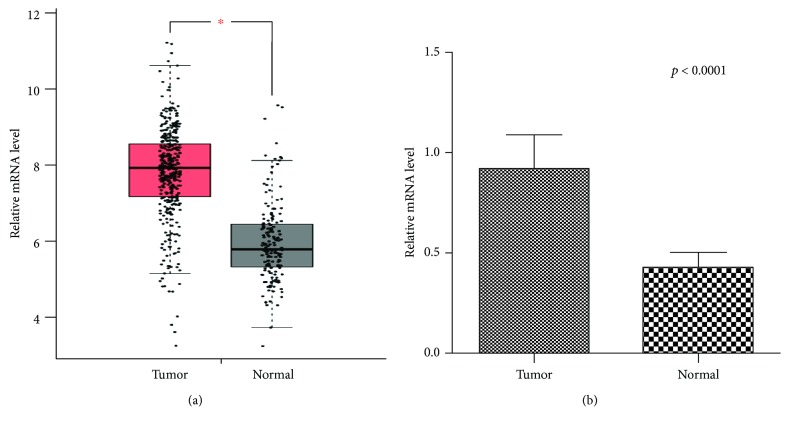
qRT-PCR analysis of ANXA2P2 expression levels in tumor and nontumor tissues of hepatocellular carcinoma patients. (a) 369 cases of hepatocellular carcinoma (HCC) tissues and 160 cases of adjacent nontumor tissues from TCGA dataset. (b) 49 pairs of tumor and nontumor tissues of HCC patients in the validation group. The ANXA2P2 expression level in tumor tissues is remarkably higher than that in nontumor tissues of HCC patients (p < 0.0001).